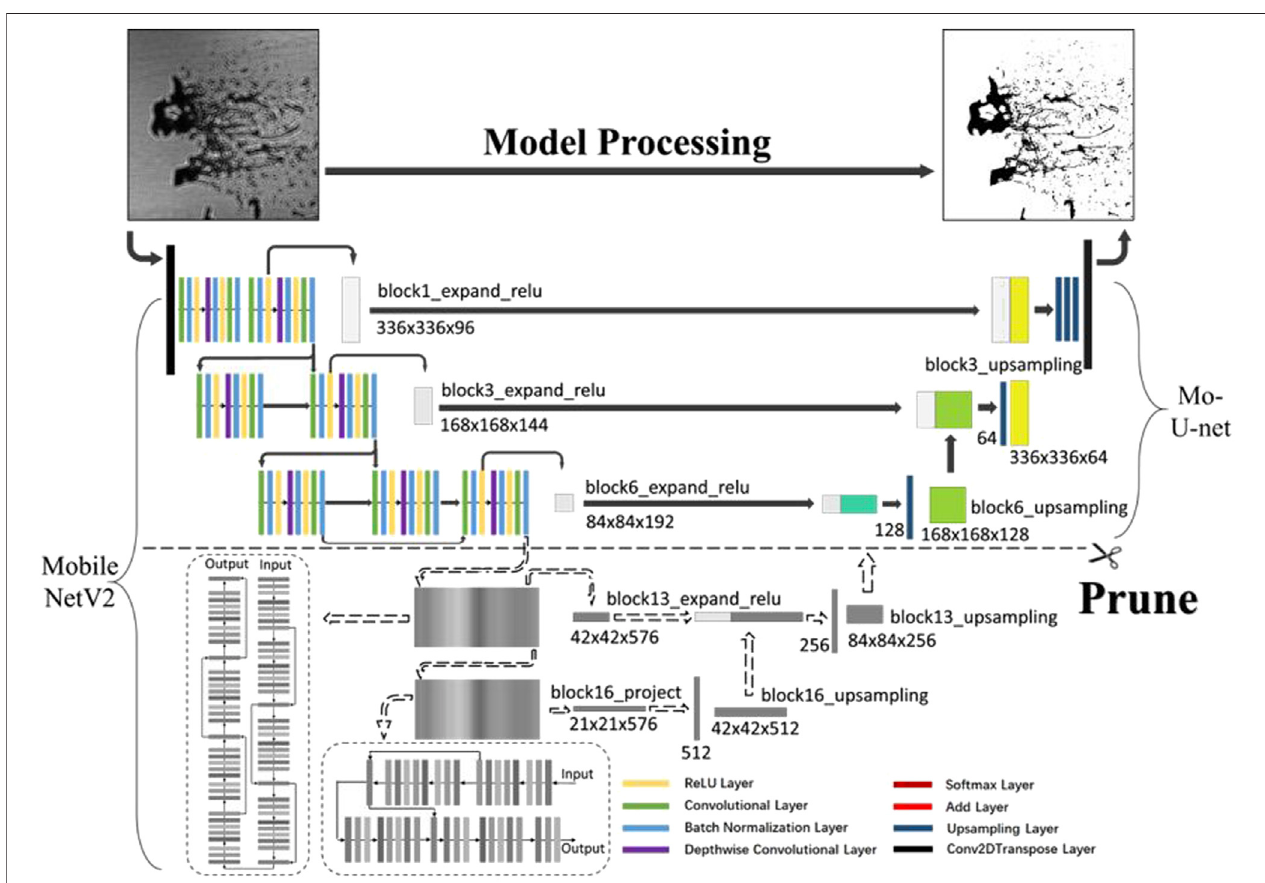
FIGURE 3 | The structure of Mo-U-net. The blocks and arrows marked as gray areas denote the parts that are pruned in actual use.